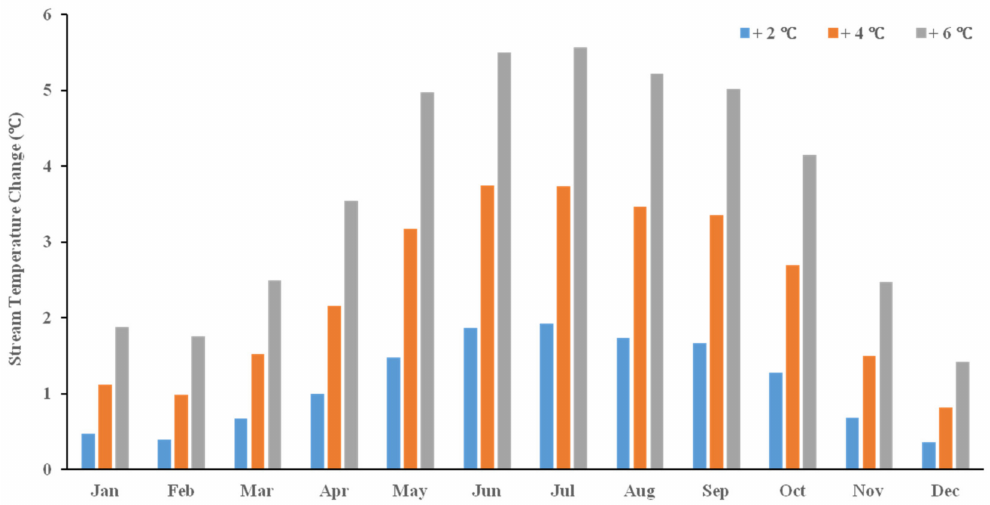
Figure 8. Stream temperature sensitivity to air temperature increase in the